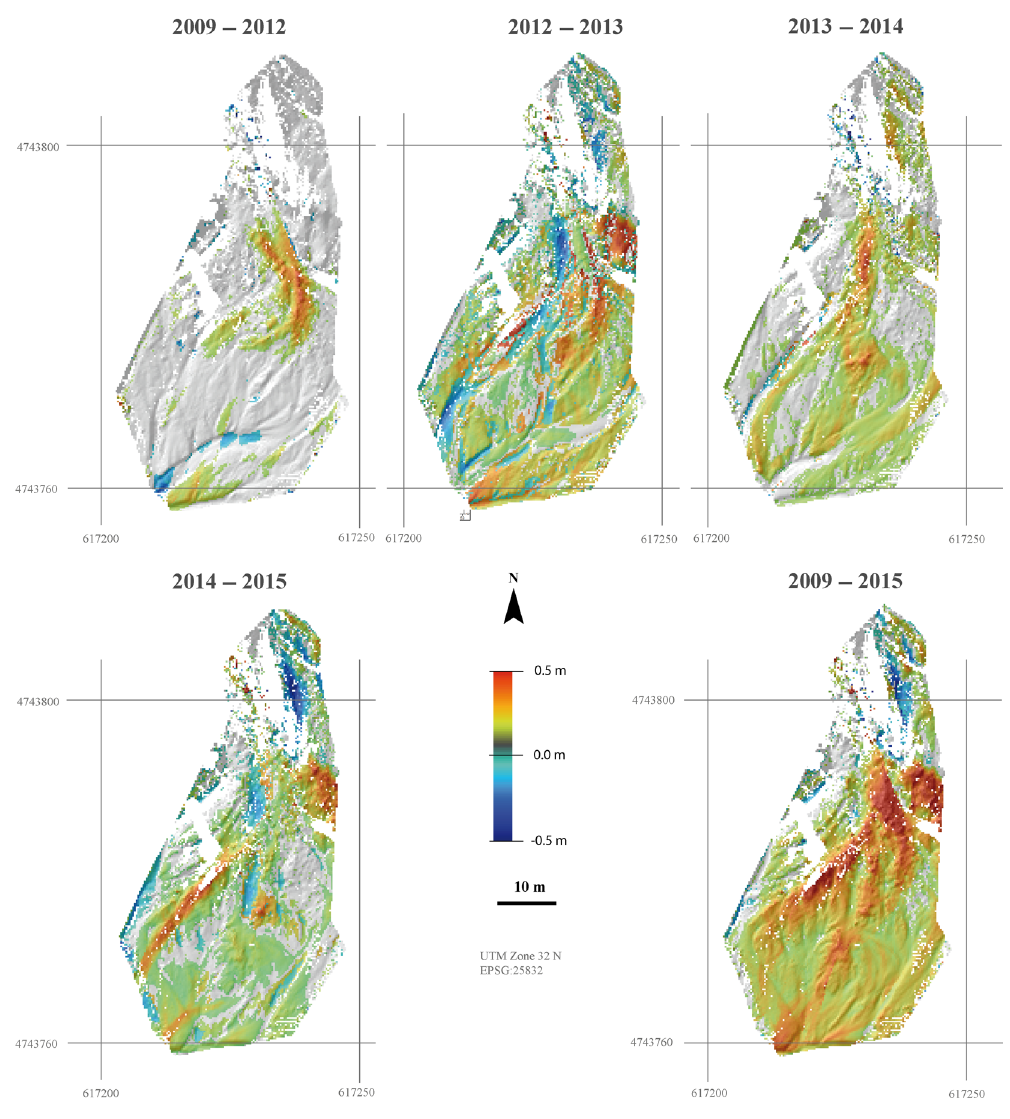
Figure 9. Surface changes (over the LoD) in the reservoir for the single epochs between 2009 and 2015 derived on the basis of the TLS